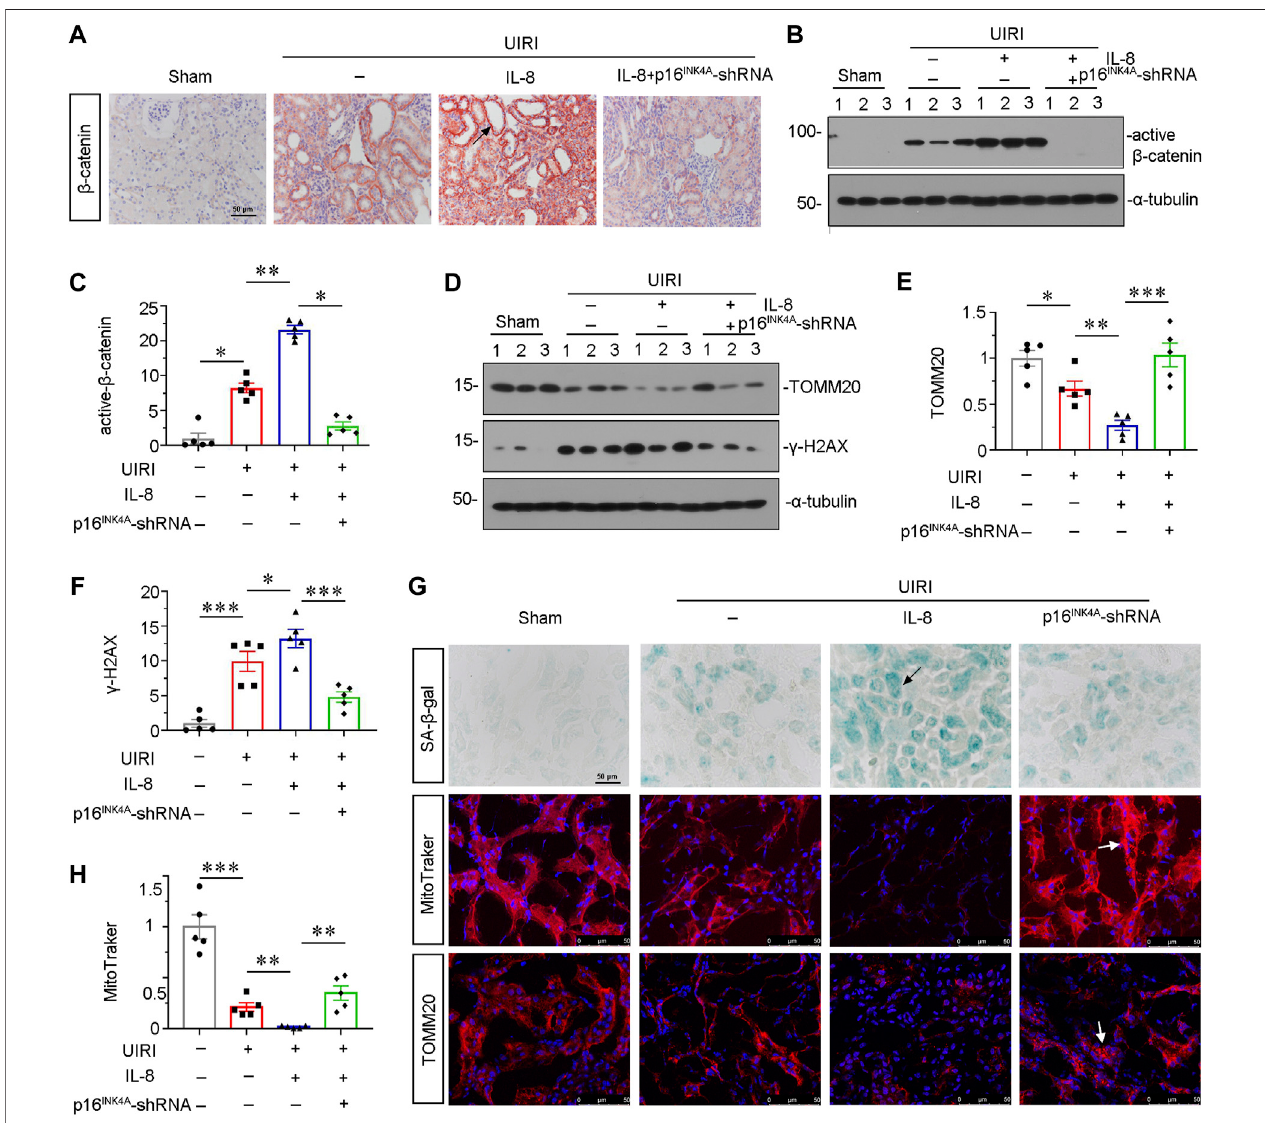
FIGURE 5 | Knockdown of p16 INK4A inhibits IL-8-induced tubular senescence and mitochondrial dysfunction in UIRI mice. (A) Representative micrographs showing β -catenin expression in four groups, as indicated. Paraf fi n-embedded sections were stained with β -catenin antibody. Arrows indicate positive staining. Scale bar, 50 μ m. (B,C) Representative western blot analysis and quantitative data show the protein level of active β -catenin in four groups. * p < 0.05, ** p < 0.01, n = 5. (D – F) Representativewesternblotanalysisandquantitativedatashow (E) TOMM20and (F) γ -H2AXexpressionindifferentgroups.* p < 0.05,** p < 0.01,*** p < 0.001, n = 5. (G) RepresentativemicrographsshowingSA- β -gal,MitoTracker andTOMM20stainingsinfourgroups,asindicated.FrozensectionswerestainedusingSA- β -galkit, and by MitoTraker staining, or were also stained with TOMM20 antibody, respectively. Arrows indicate positive staining. Arrows indicate positive staining. Scale bar, 50 μ m. (H) Quantitative graph of MitoTraker staining showing mitochondrial mass in four groups. ** p < 0.01, *** p < 0.001, n =